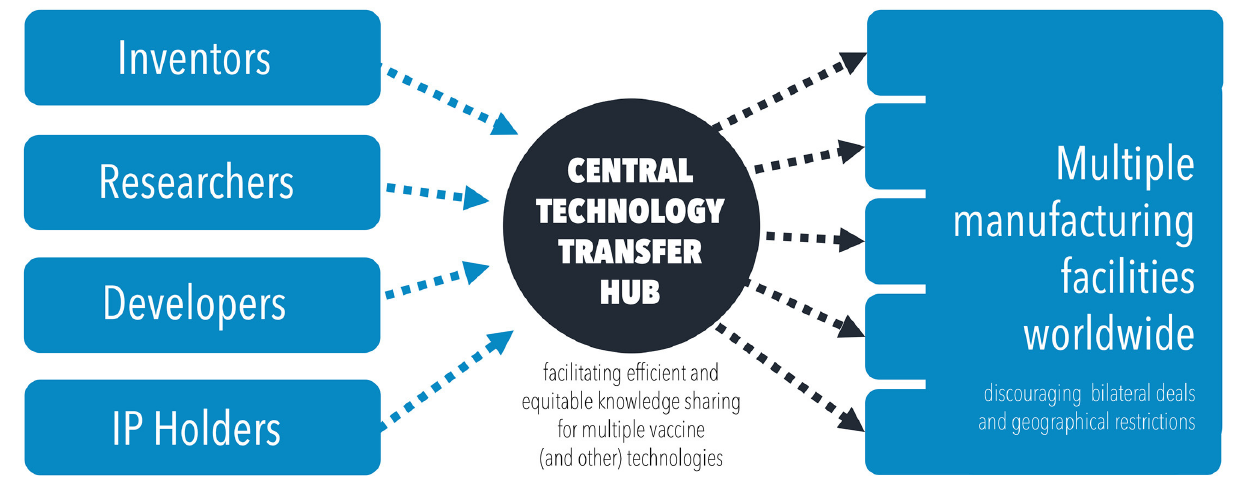
FIGURE 3 | Diagram illustrating the flow of knowledge and technology transfer through a centralized technology transfer hub, to disseminate information and scale up manufacturing